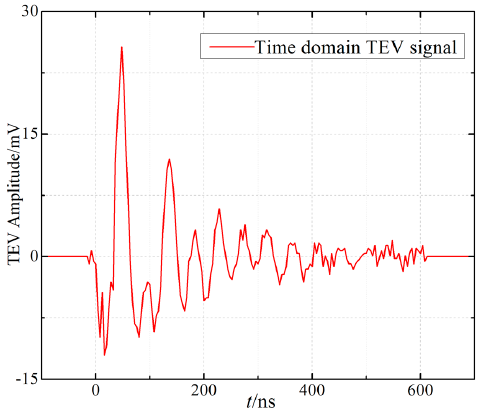
Figure 7. Time-resolved PD pulse waveform based on the designed TEV coupling module.